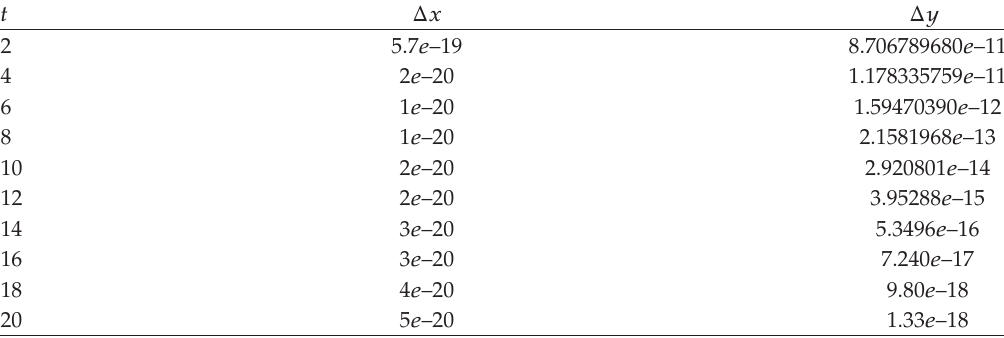
Table 1: The absolute error from the MSHAM 0 . 001 and RK4 0 . 001 for Case 2 of the prey-predator problem.